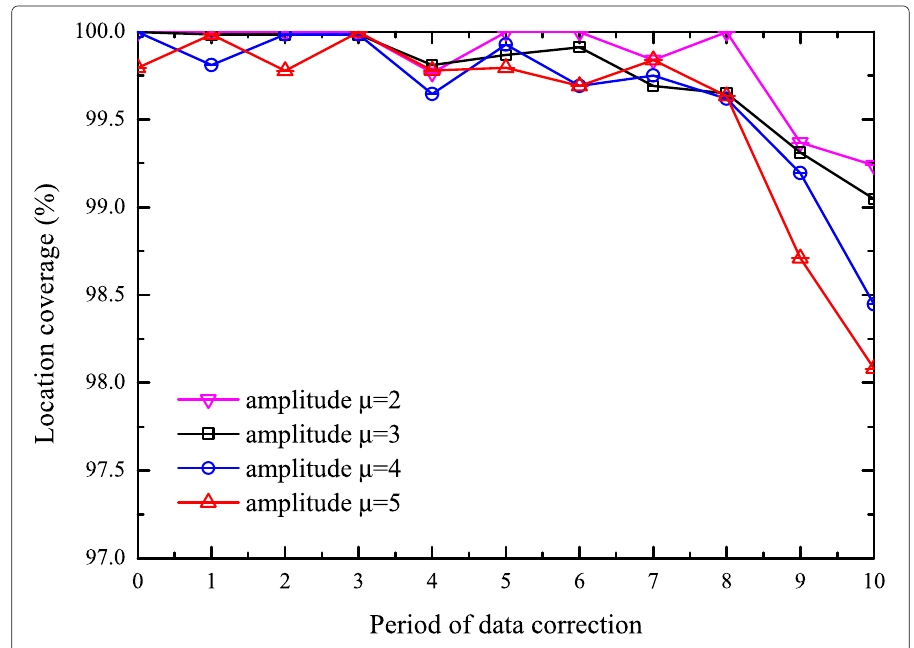
Fig. 8 Change of location coverage with current amplitude during 10